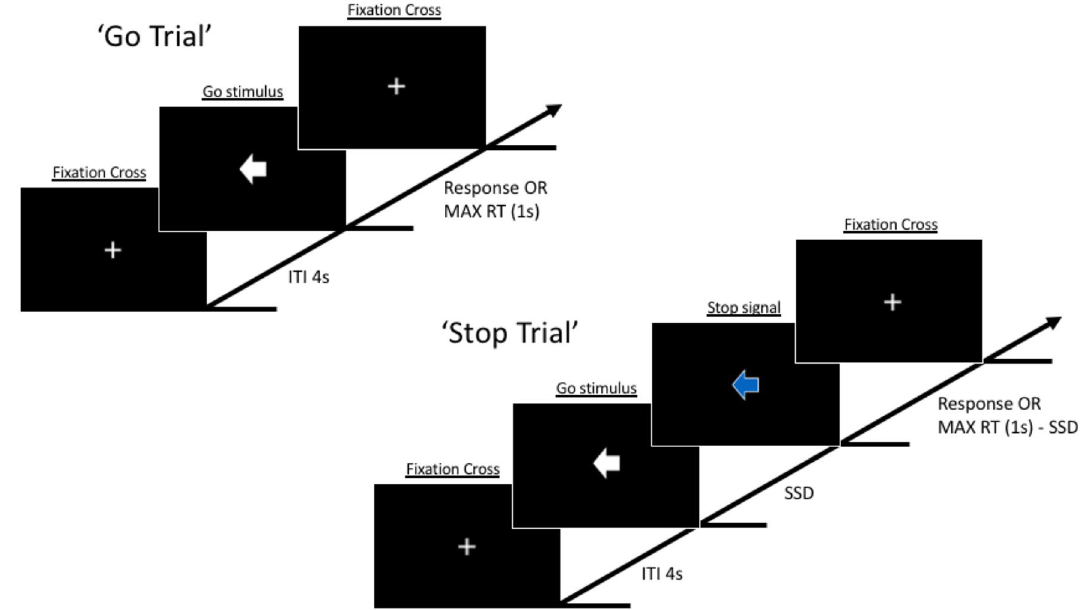
Figure 3. Visual representation of the sequence of events in the Stop Signal Task employed in the present